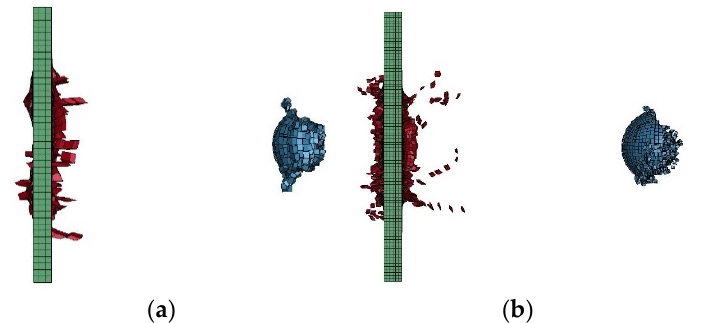
Figure 18. Debris cloud contours under different mesh sizes. ( a ) Mesh size 0.8 mm; ( b ) mesh size 0.4 mm.